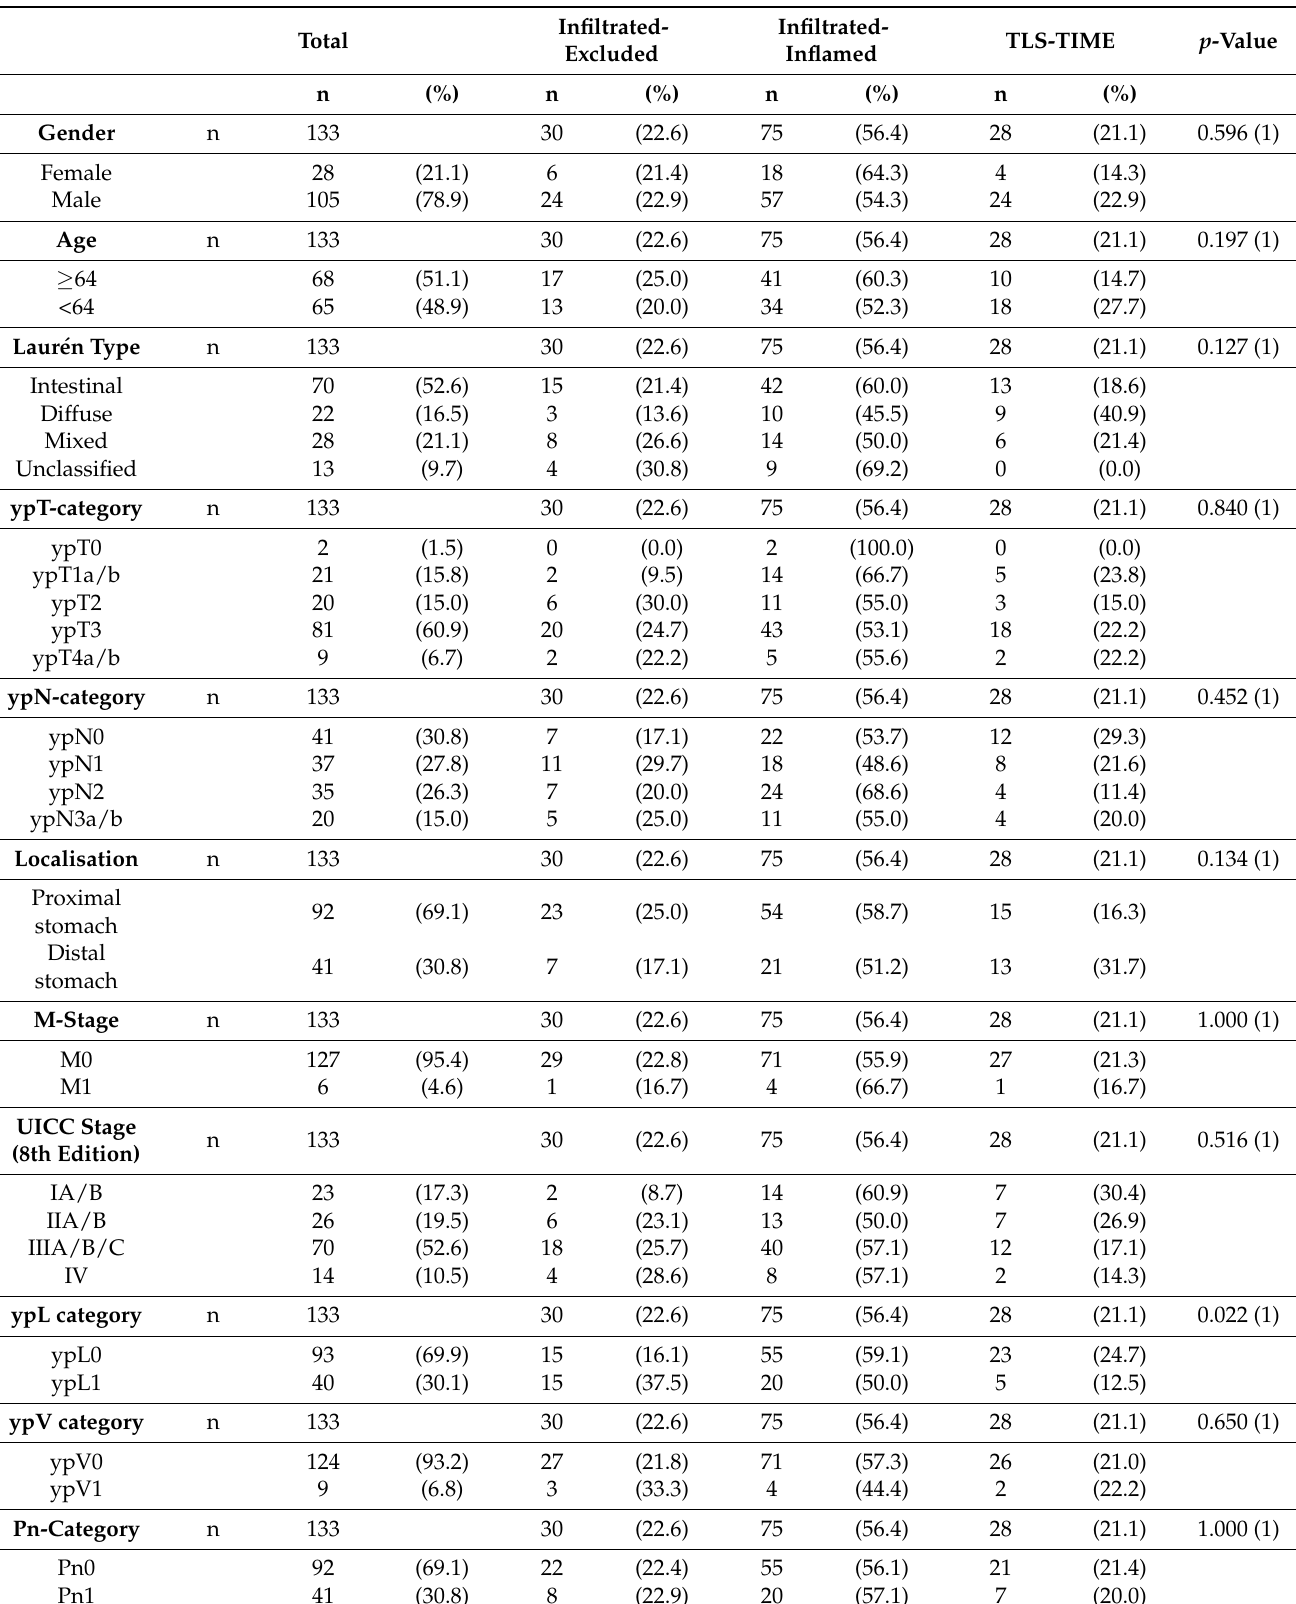
Table 3. Correlation between tumor immune microenvironment (TIME) and clinicopathological patient characteristics.